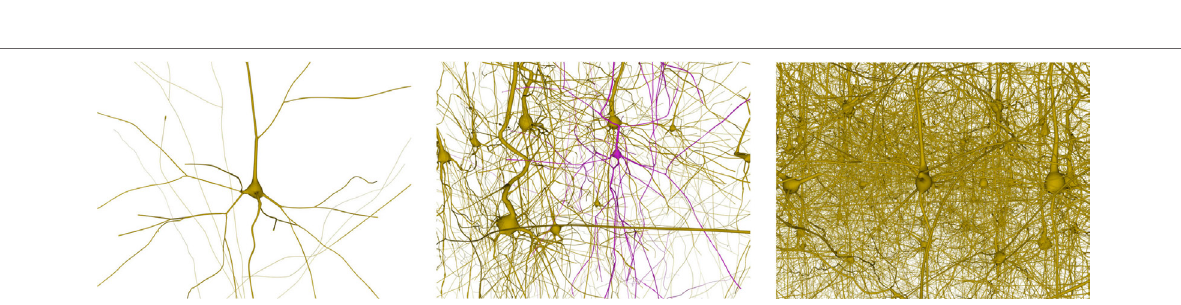
FIGURe 13 | Top images: close view of a generated neurite fork junction rendered in shading mode (left image) and wireframe mode (right image). Bottom images: close view of soma–neurite junction for neuron meshes with homogeneous level of detail (left image) and adaptive level of detail based on the camera distance (right image).